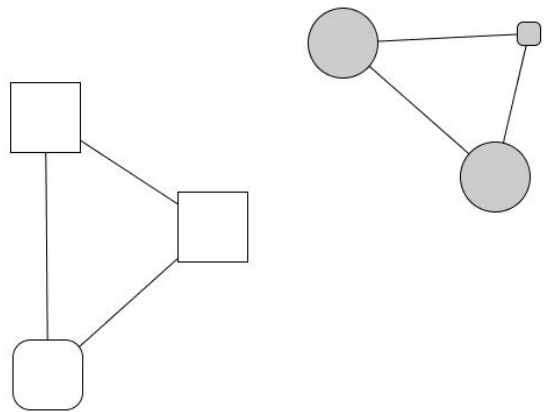
Figure 6. Evaristo’s personal network. Node color indicates type of relationship: family members (black), friends and acquaintances (gray), and professionals (white). Node size indicates ego’s perception of alter’s status: big size (ego perceives that “alter has a better socioeconomic situation than me”), average size (ego perceives that “alter has a similar situation as me”) and small size (ego perceives that “alter has a worse socioeconomic situation than me”). Node shape indicates length of relationship: triangle (less than 1 year of relationship), square (between 1 and 5 years of relationship), rounded rectangle (more than 5 years) and circle (lifetime).